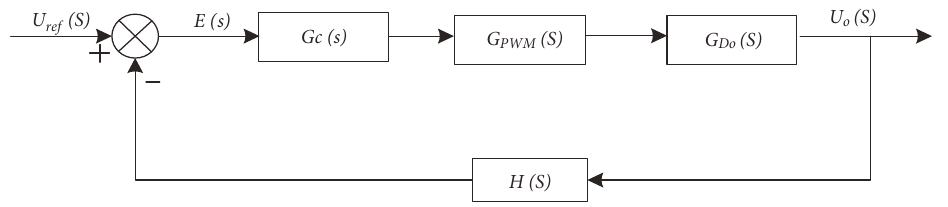
Figure 11: Voltage loop control scheme of the DS-HS converter. Table 3: The design index and component